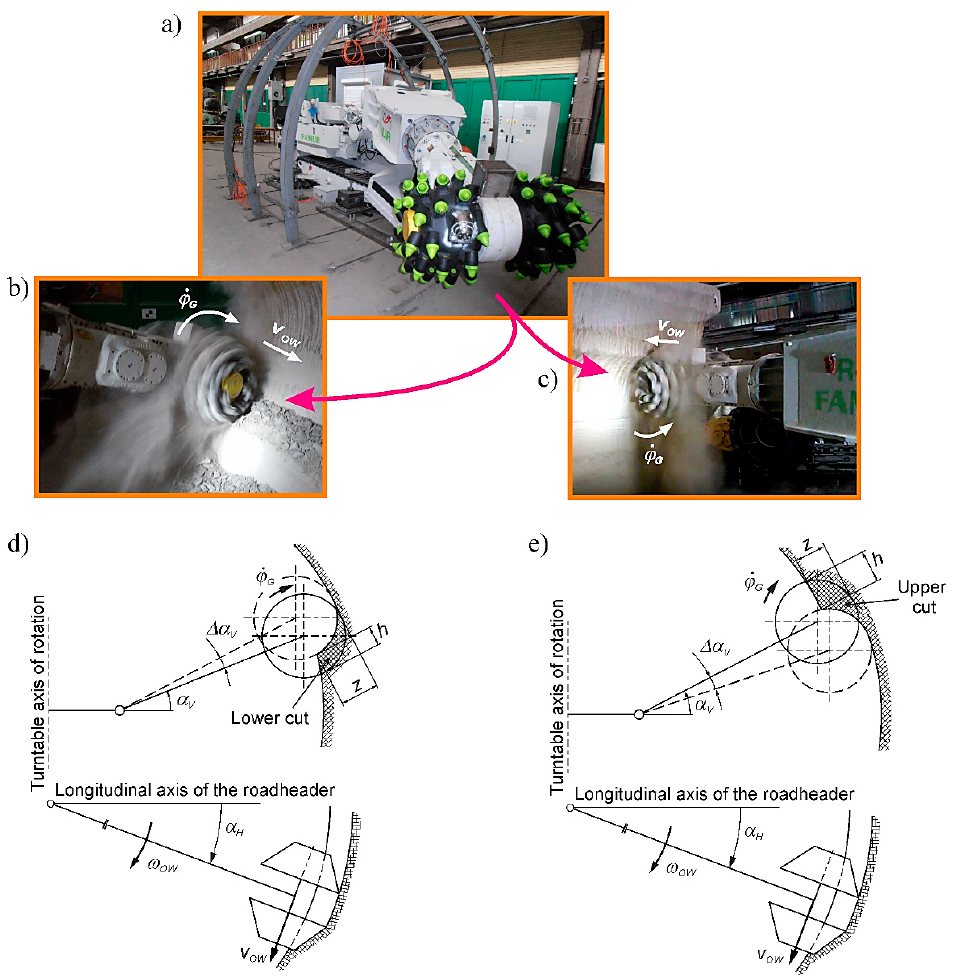
Figure 1. Test object: ( a ) roadheader R-130 (manufactured by Famur SA) on the experimental stand, ( b ) the course of the lower cut, ( c ) the course of the upper cut, ( d ) parameters characterizing the lower cut, and ( e ) parameters characterizing the upper cut.